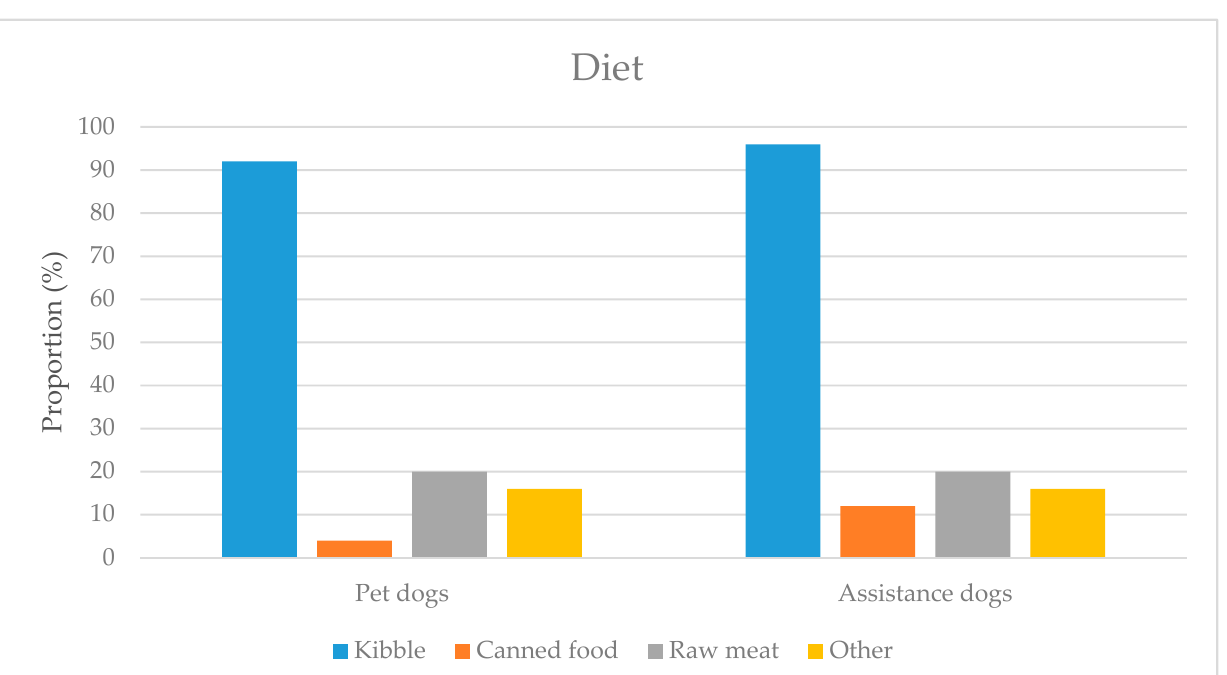
Table 4. Unadjusted odds ratios (ORs) and their 95% confidence intervals (95% CIs) for the possible factors in the univar- iable models with p -values < 0.25, linked to the presence or absence of colony-forming units (CFUs) of the Enterobacteri- aceae family, recovered from dog paws.